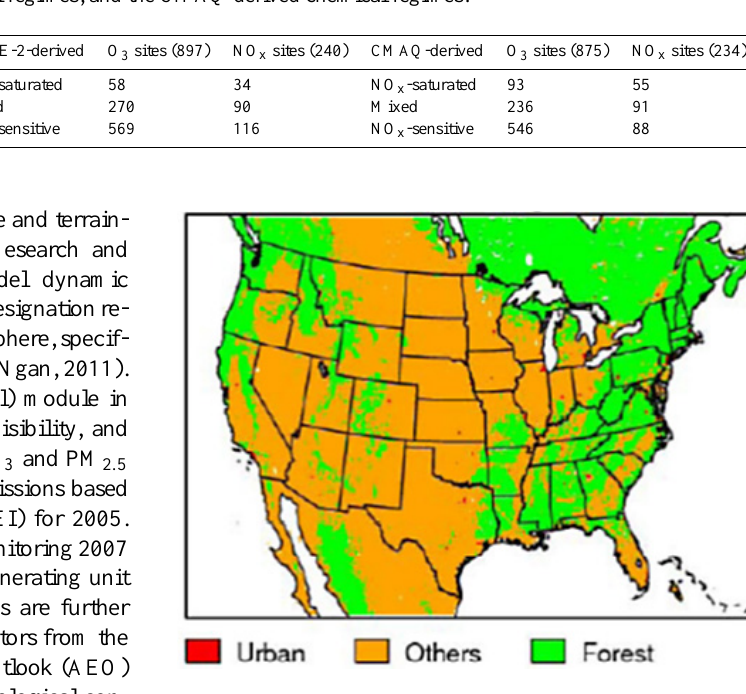
Table 1. The total number(one-month averages) of CMQ grids, including EPA AQS O 3 and NO x measurement sites over the AVHRR-derived geographical regions, the GOME-2-derived chemical regimes, and the CMAQ-derived chemical regimes.